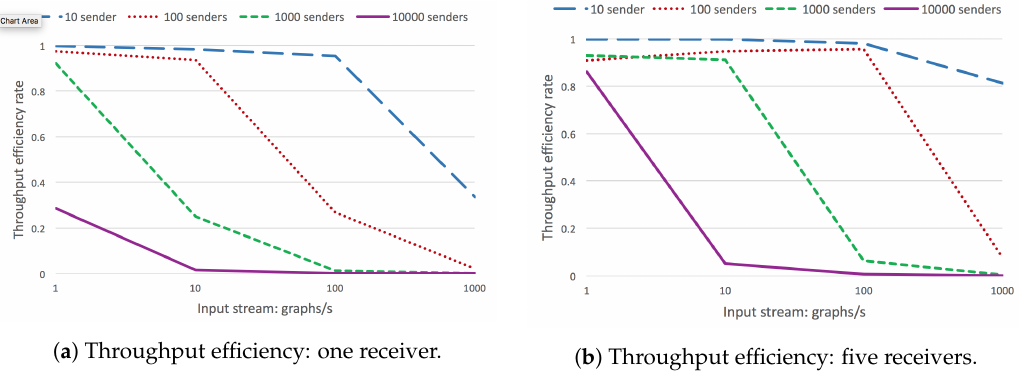
Figure 21. Throughput efficiency vs. input stream rates, for different sets of concurrent senders.